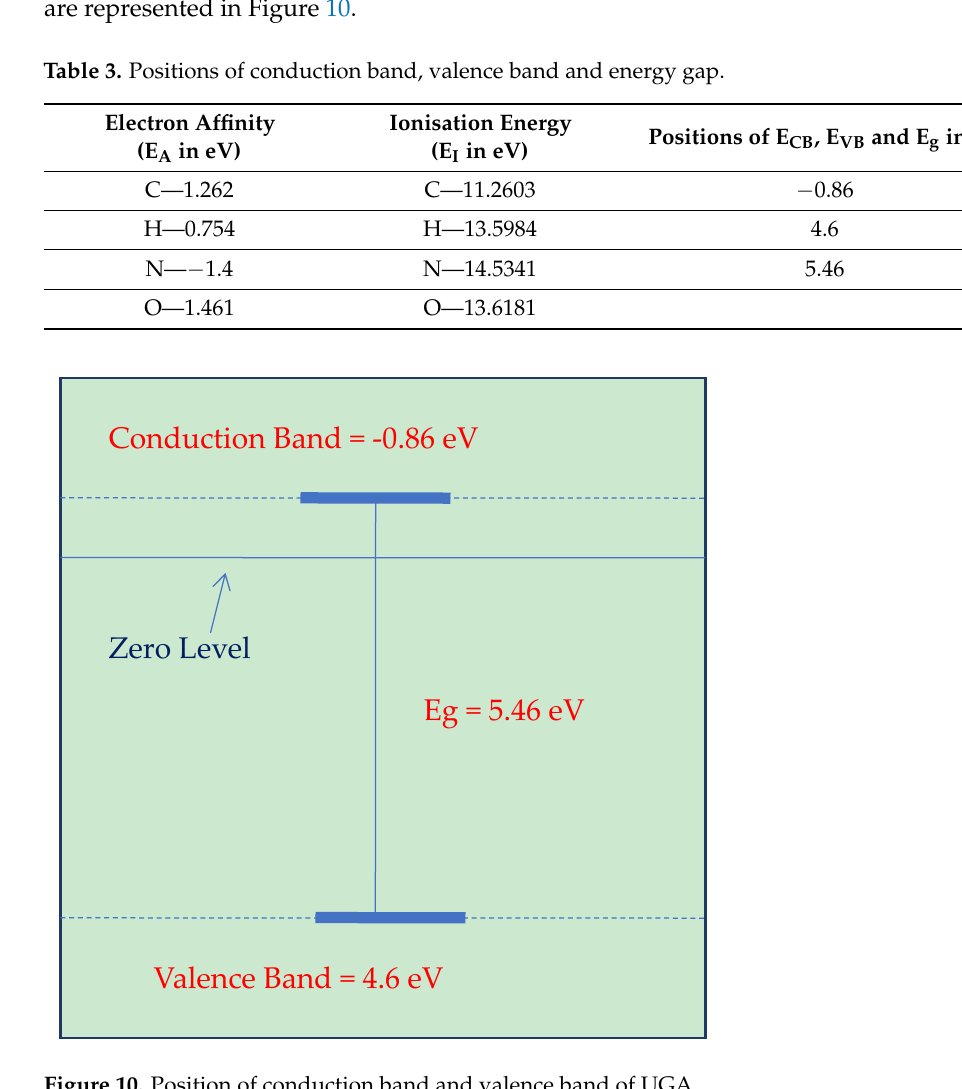
Figure 10. Position of conduction band and valence band of UGA. Table 3. Positions of conduction band, valence band and energy gap.